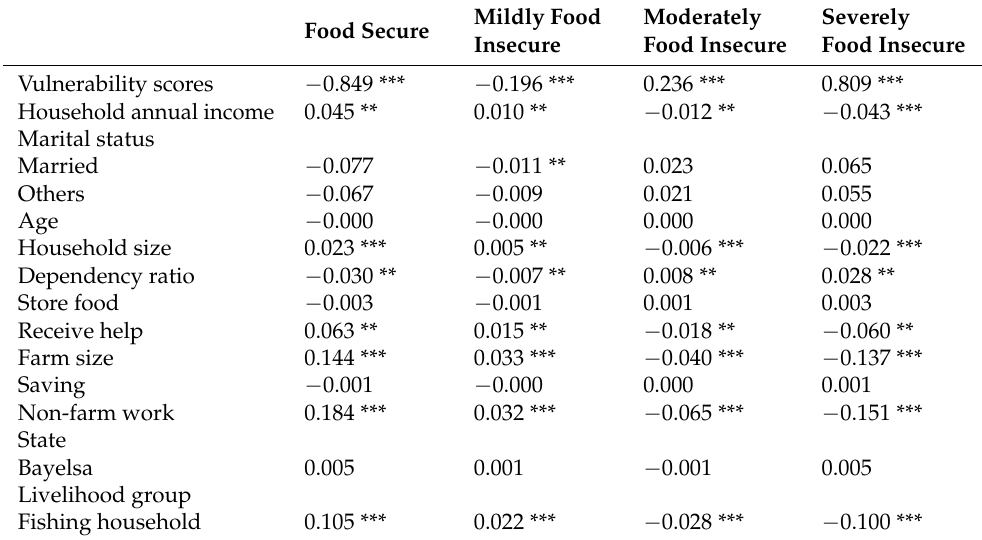
Table 7. Marginal Effects associated with the Ordered Logit